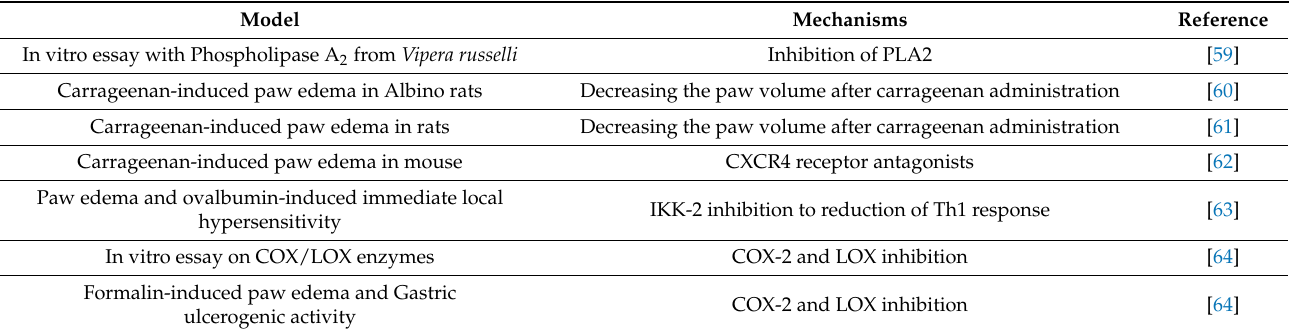
Table 3. Summary of the active thiophene-based compounds in classic models of inflammation.